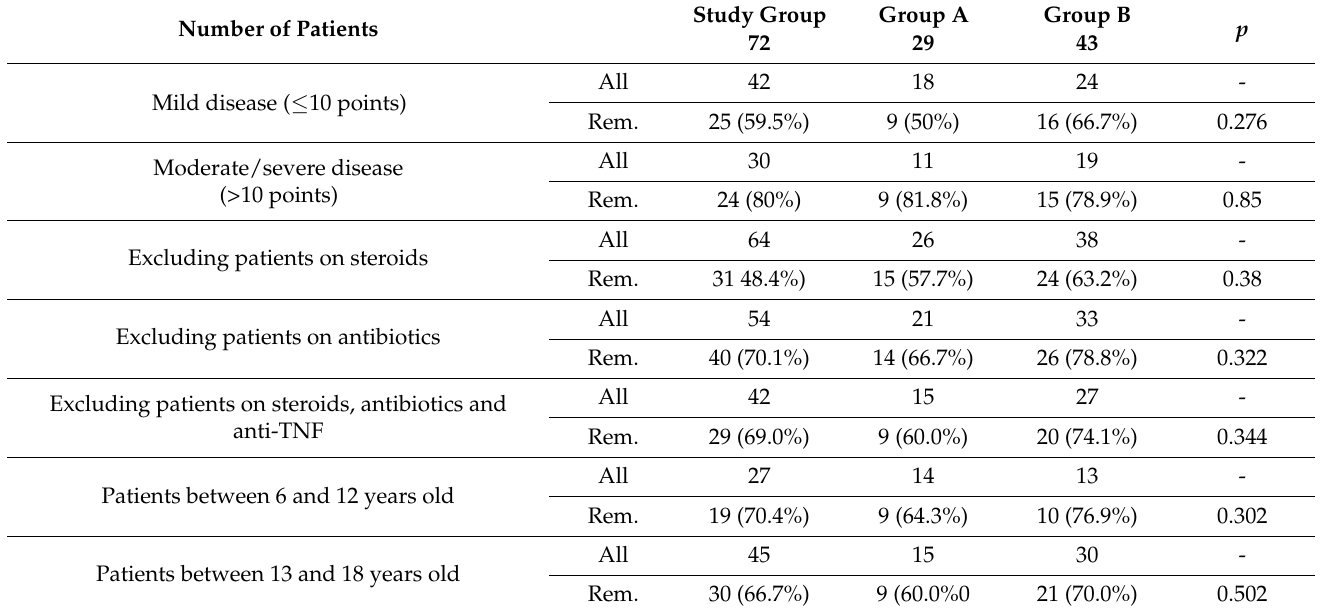
Table 2. Comparison of butyrate effectiveness as an add-on therapy in achieving remission in different